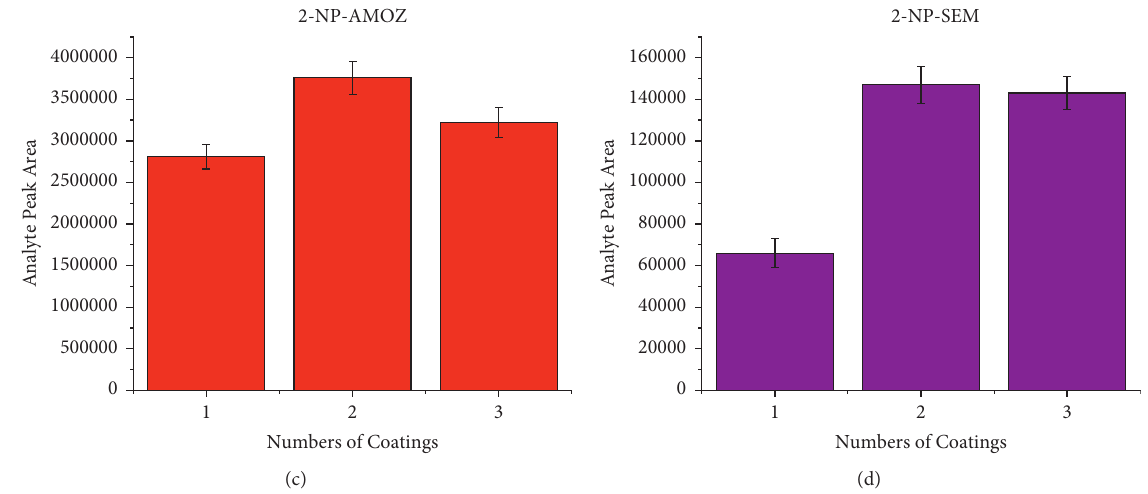
Figure 3: Effect of extraction phase thickness on the SPME